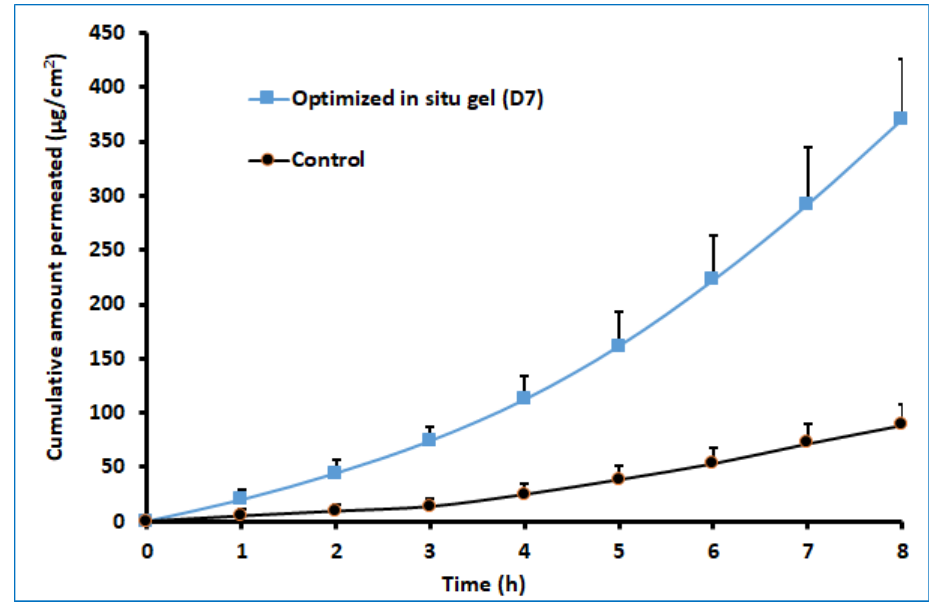
Figure 10. Comparison of ex vivo darunavir permeation using isolated sheep nasal mucosa from optimized in situ gel and control (suspension). The data presented are the average ± SD ( n = 6).